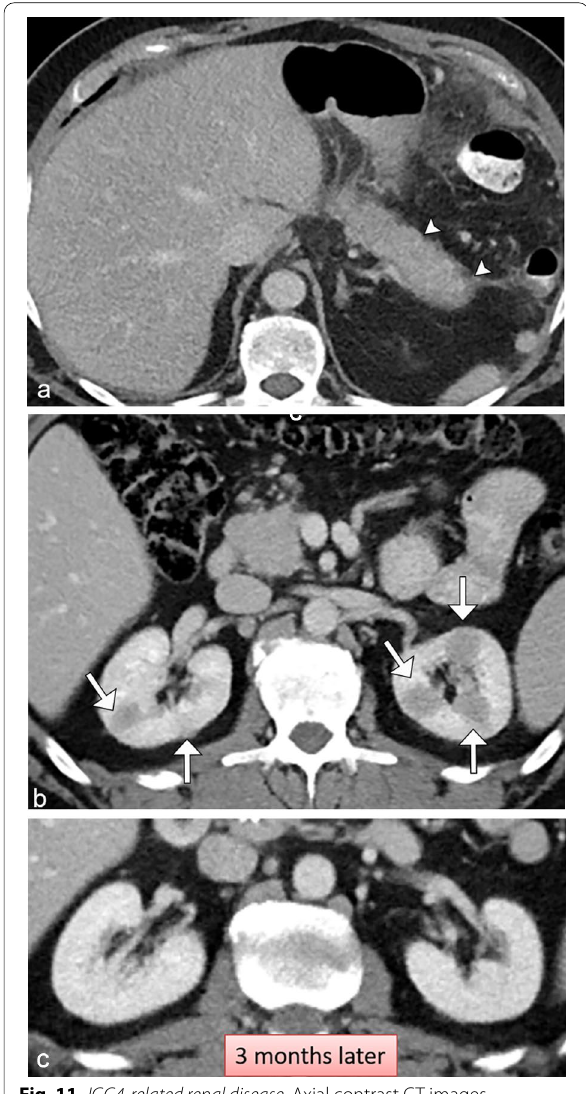
Fig. 11 IGG4-related renal disease . Axial contrast CT images demonstrate ( a ) a sausage-shaped pancreas with loss of normal pancreatic lobulations and presence of a hypoattenuating surrounding halo/capsule (arrowheads) consistent with IGG4-related autoimmune pancreatitis. ( b ) Bilateral hypoattenuating renal masses (arrows) were present compatible with IGG4-related renal disease in light of the pancreatic findings, mimicking the multiple masses of lymphoma. Axial contrast CT 3 months later ( c ) post-treatment with steroids demonstrates resolution of the renal masses confirming the initial